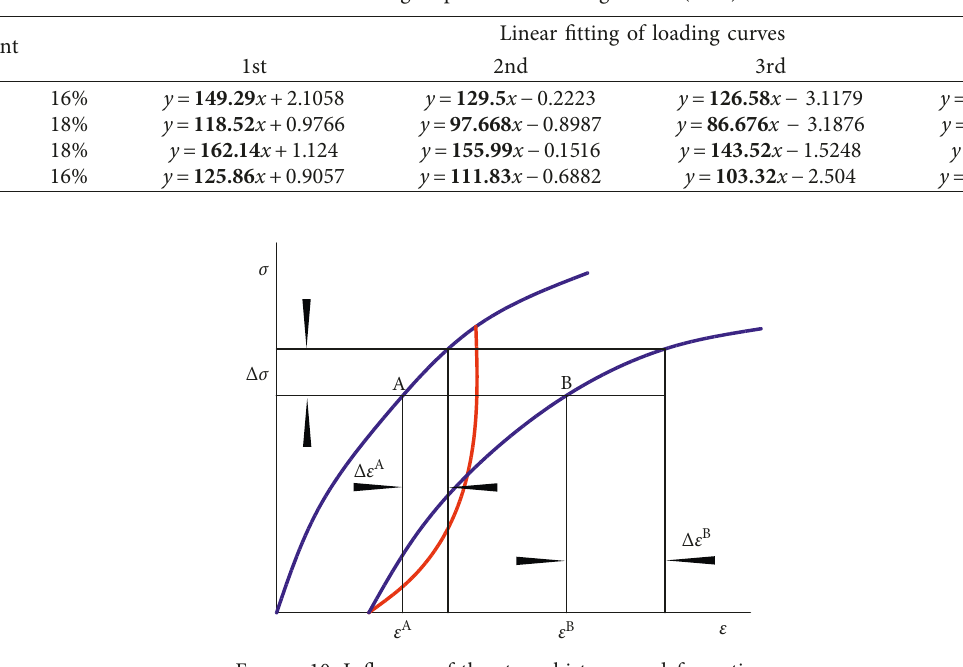
Figure 9: Stress-strain curves of the cyclic tensile tests for loading pattern II: (a) w � 16%; (b) w � 18%. Table 4: Fitting slopes of the loading curves ( σ × ε ).